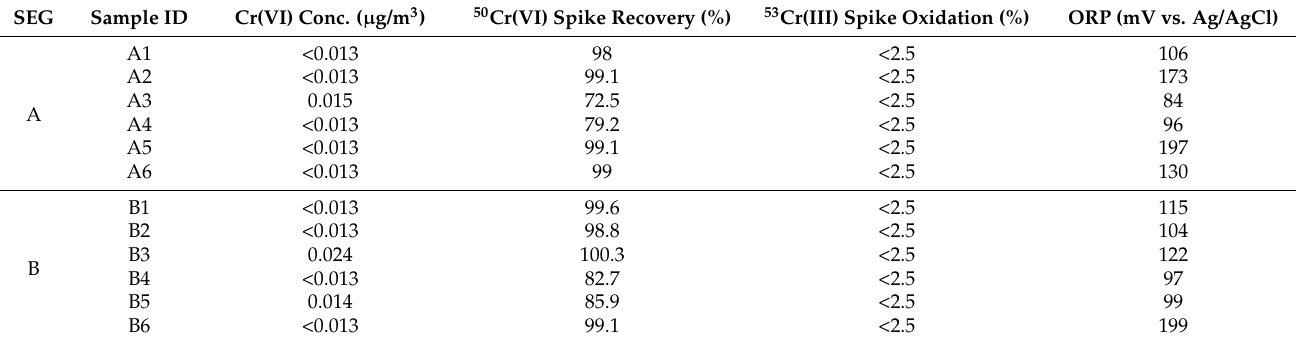
Table 5. Cr(VI) occupational exposure detected with the ISO-modified extraction protocol through personal sampling in two SEGs of tanned leather shavers (same workers, location, and time span of samplings of Table 3). Data of spikes recoveries/oxidations are presented, together with ORP values determined after extraction.